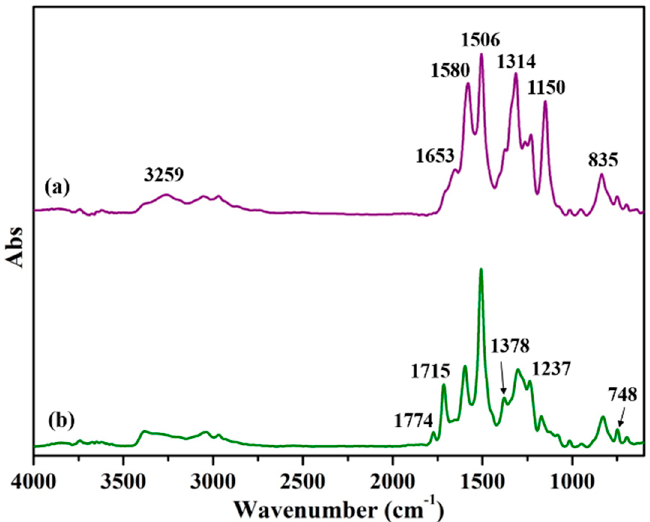
Figure 2. ATR-FTIR spectroscopies of ( a ) EAAO and ( b ) EIO.